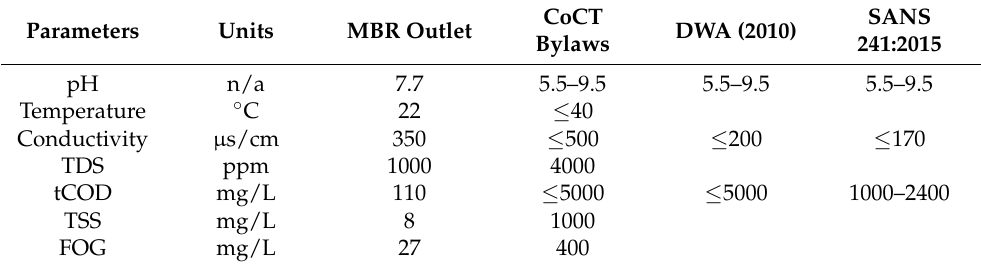
Figure 22. 3D plot of the overall performance (COD VS TSS). Table 1. Results obtained from the MBR final effluent compared to